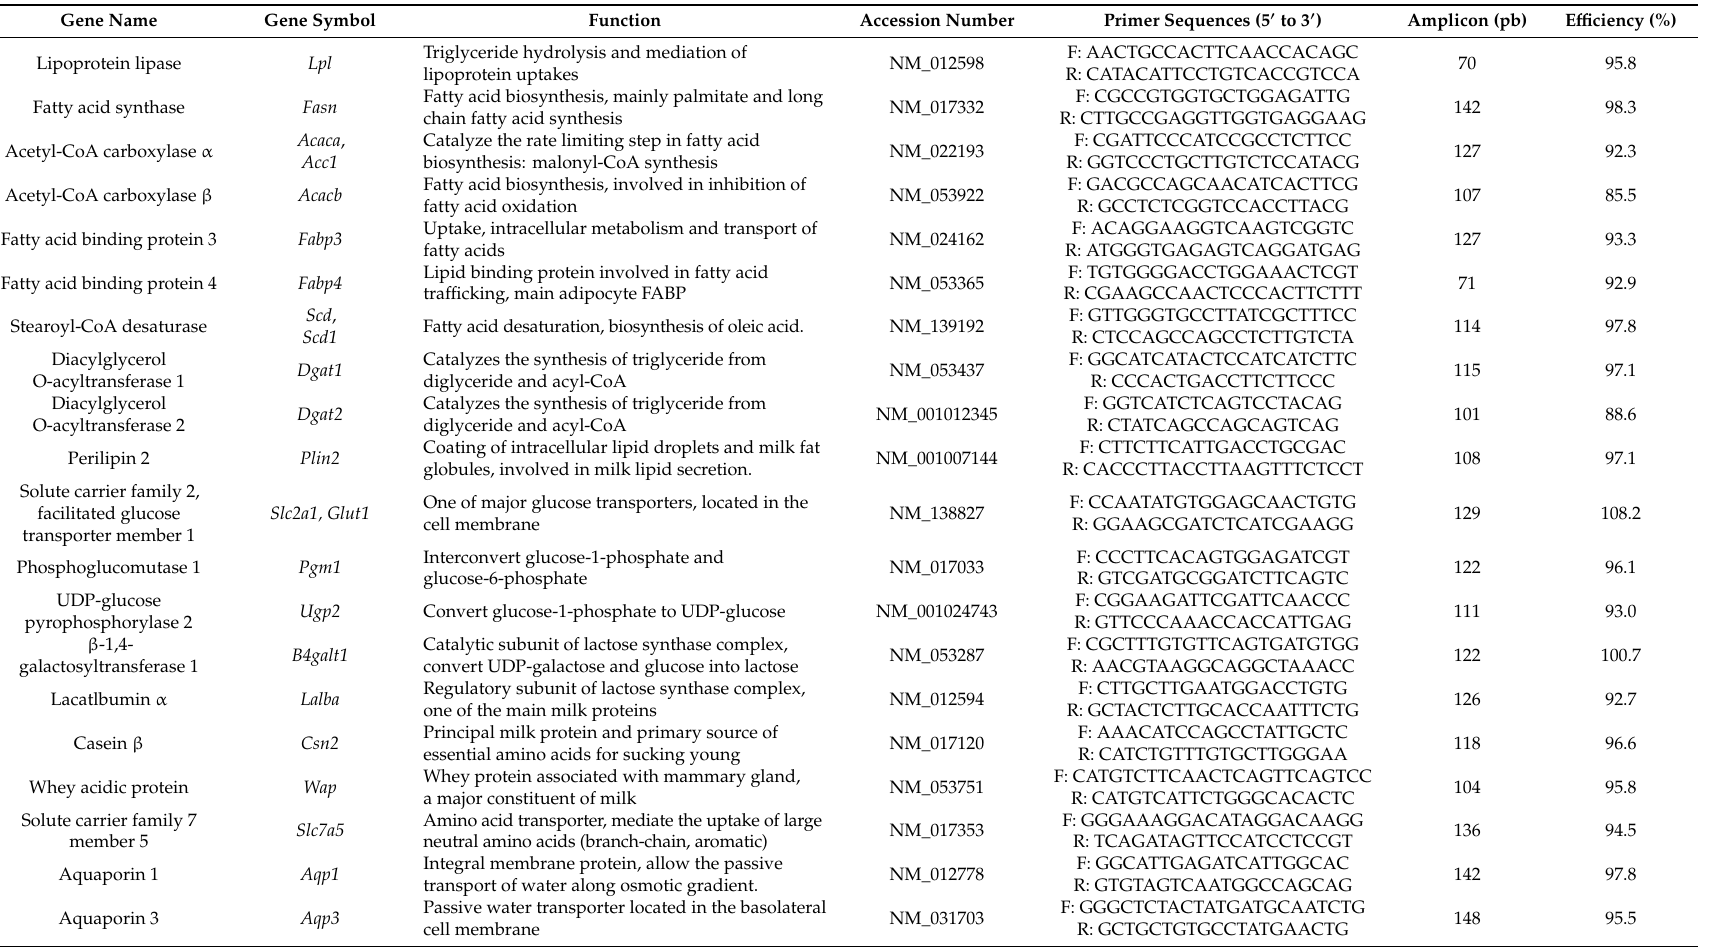
Table A1. List of the primers’ sequences used to measure each gene by qPCR with the amplicon size and the e ffi